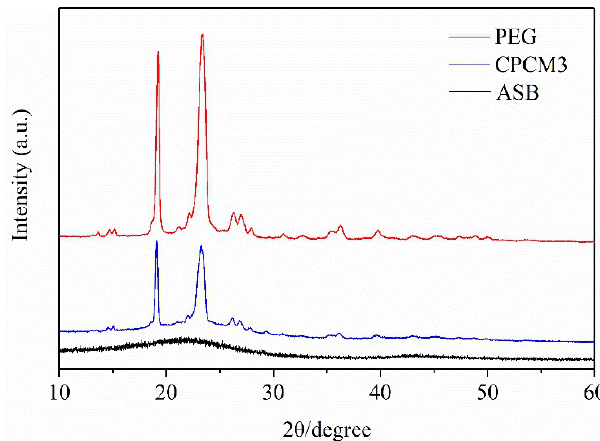
Figure 4. X-ray diffraction (XRD) patterns of PEG, CPCM3 and ASB. a.u.: arbitrary unit.